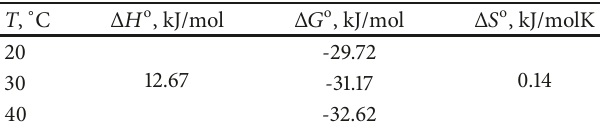
Table 6: Thermodynamic parameters for BG